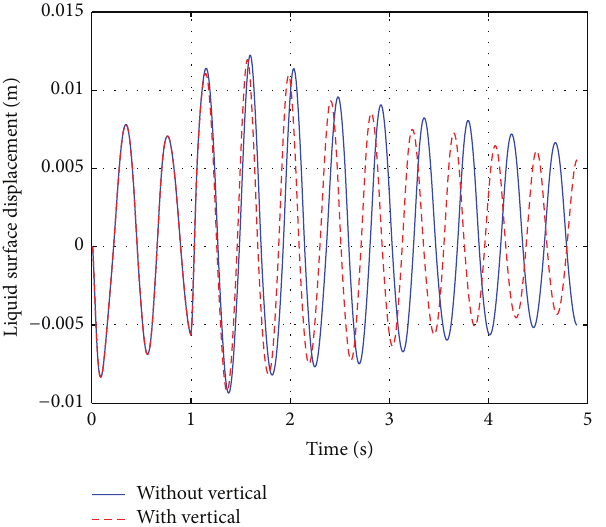
Figure 14: Comparison of the simulated sloshing under vertical acceleration.